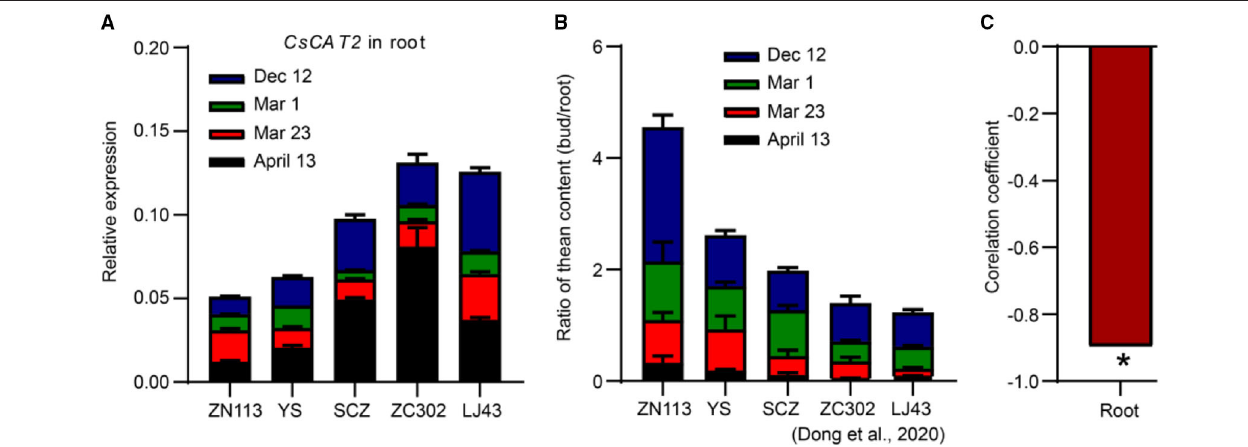
FIGURE 6 | Correlation between CsCAT2 expression in the roots and the efficiency of theanine root-to-shoot transport. (A) CsCAT2 expression in the roots of 5 tea plant cultivars at the four time points. CsGAPDH was used as an internal control. (B) The ratios of theanine in the bud to that in the root in different tea plant cultivars. The data are from Dong et al. (2020). (C) Correlation between the summation of CsCAT2 expression (B) and the ratios (C) was analyzed using Pearson’s correlation. ZN113, Zhenong 113; YS, Yingshuang; SCZ, Shuchazao; ZC302, Zhongcha 302; LJ43, Longjing 43. Data were analyzed using one-way ANOVA, * p < 0.05.